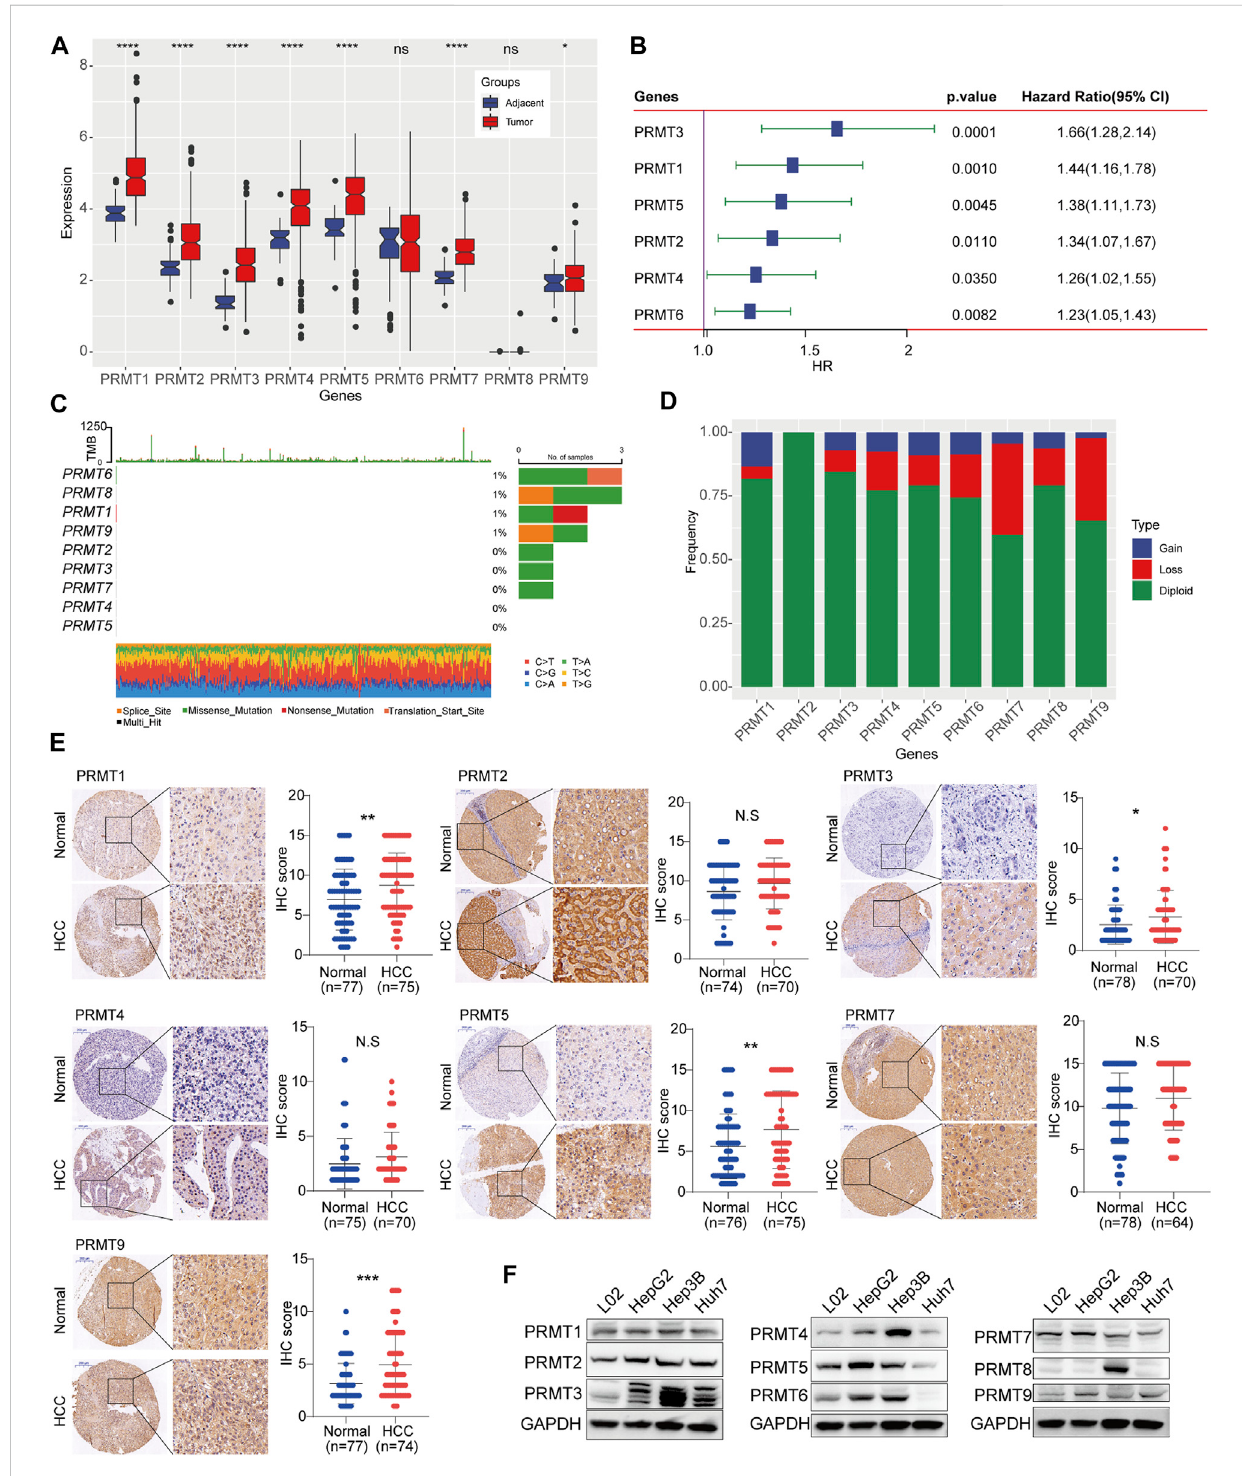
FIGURE 1 Expression and mutation status of PRMTs in HCC (A) The expression pro fi ling of 9 PRMTs between HCC tissues and adjacent normal tissues. (B) PRMTs signi fi cantly associated with the prognosis of HCC were displayed in the forest map. (C) The waterfall plot represents somatic mutation status of 9PRMTsinHCC. (D) ThehistogramexhibitstheCNVpatternofeachPRMTfamilygenes. (E) RepresentativeimagesofIHCstainingofPRMTsinHCCTMA cohorts (left). IHC score of 7 proteins in HCC tissues and adjacent normal tissues were further quanti fi ed (right). (F) The protein level of 9 PRMTs in HCC cell lines and normal liver cell was determined by western